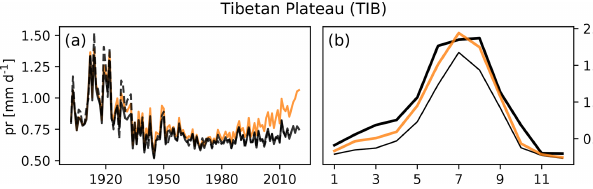
Figure 7. Panels (a) and (c) show annual regional mean time series of factual GSWP3-W5E5 data (solid black line), factual GWSP3 data (dashed black line) and counterfactual GSWP3-W5E5 data (or- ange line) for near-surface air temperature (a) and precipitation (c) over northern Europe (NEU). Panels (b) and (d) show multi-year re- gional mean climatologies for near-surface air temperature (b) and precipitation (d) of factual and counterfactual GSWP3-W5E5 data for NEU. To obtain the counterfactual annual cycle (orange line), our method aims to map the late factual (thin black line) to the early factual (thick black line) annual cycle.